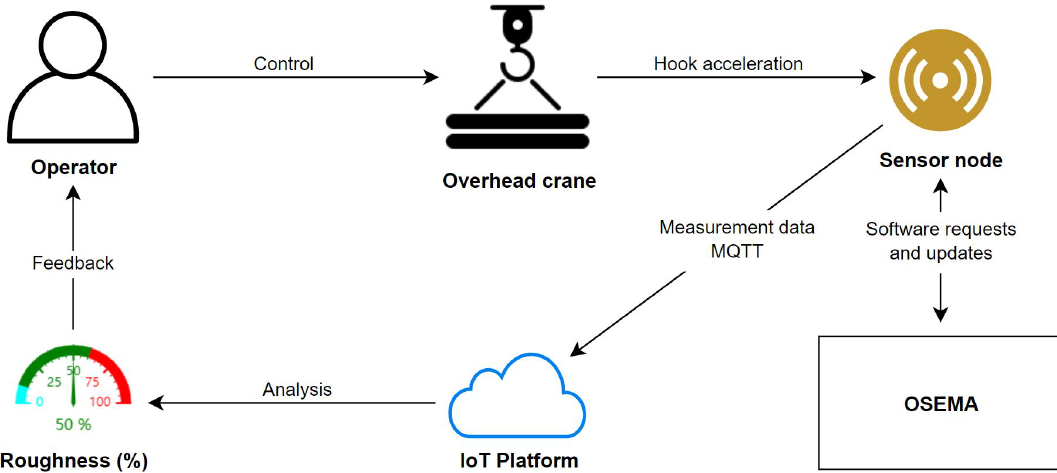
Figure 9. The system overview of the usage roughness estimation application. The operator controls the crane; a sensor measures the acceleration of the hook; and an IoT platform performs analysis based on the data and gives feedback about the driving